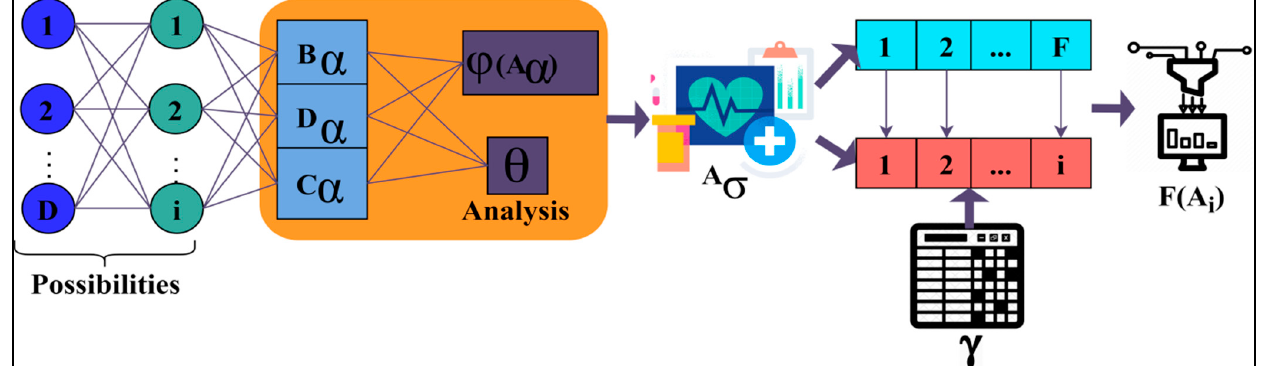
Figure 3. Combined analysis